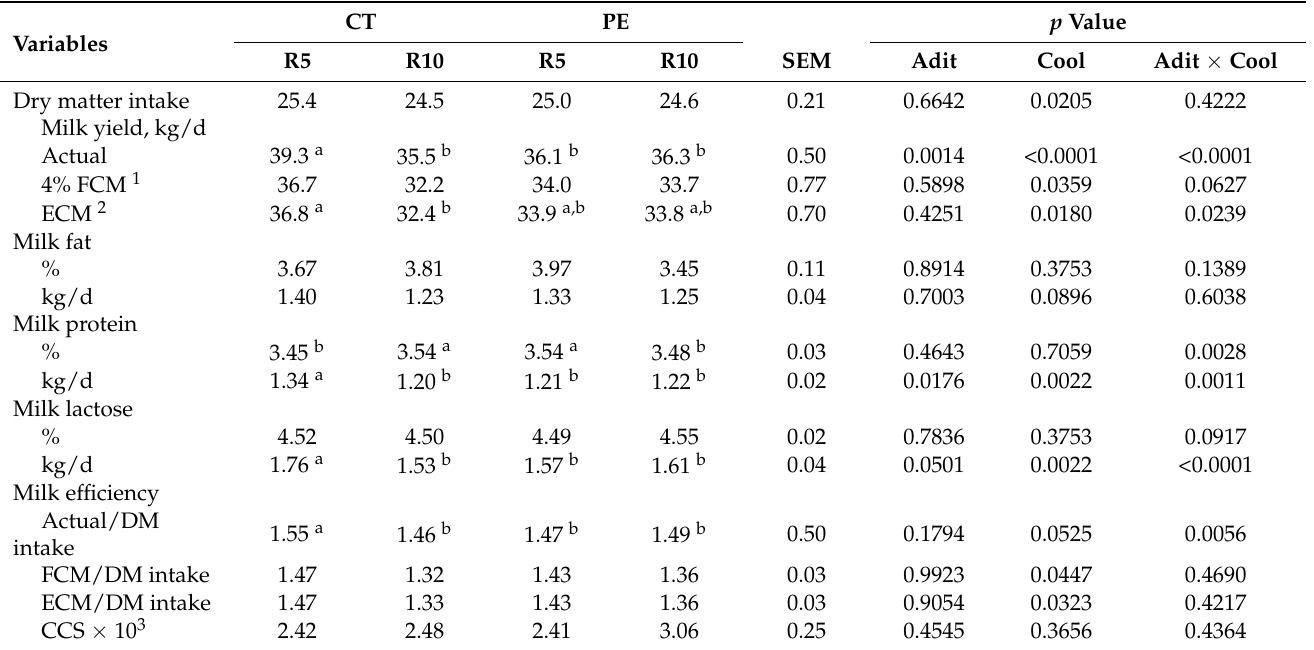
Table 6. Effects of different evaporative cooling regimens and the use or absence of PE on milk yield and milk composition of lactating Holstein cows ( n =